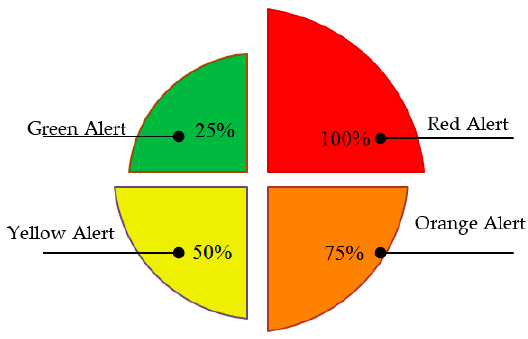
Figure 10. The warning alarm level.